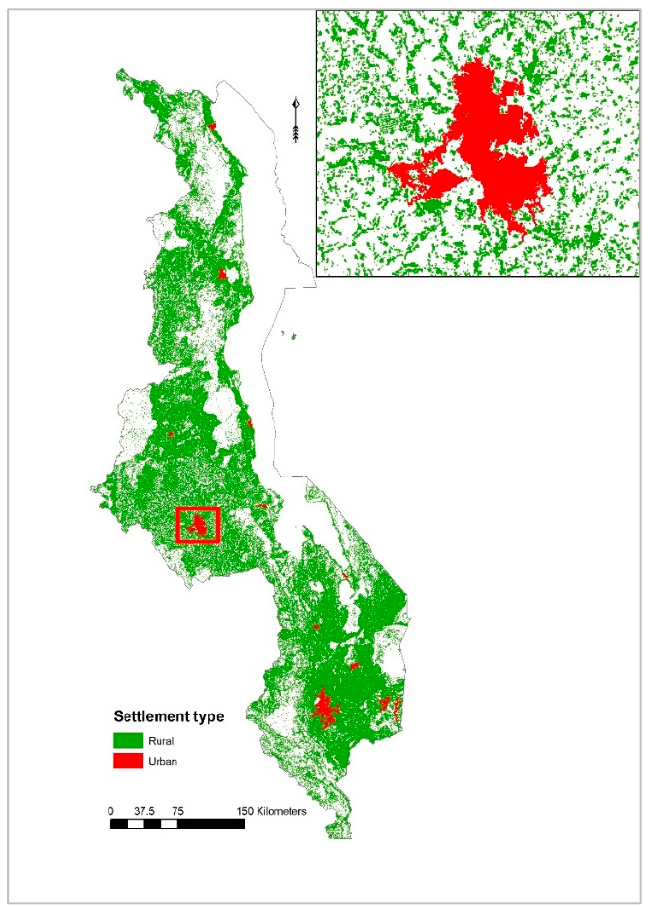
Figure 2. Characterization and spatial distribution of population clusters in Malawi as identified by the OnSSET model.